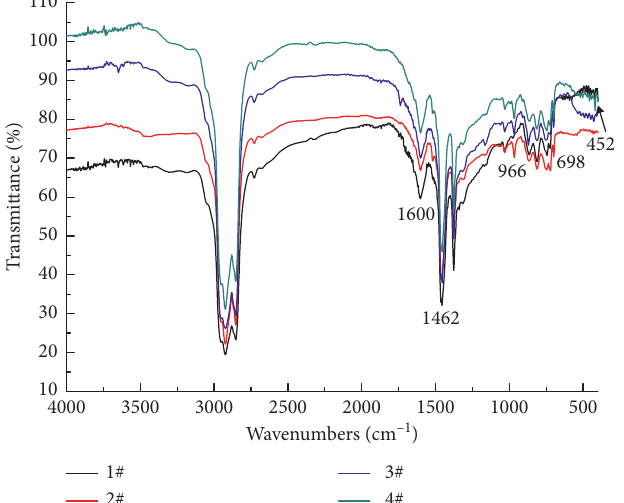
Figure 4: FTIR spectra of base asphalt and modified asphalt. 1# (base asphalt), 2# (SBS-modified asphalt), 3# (nano-ZnO/SBS-modified asphalt), and 4# (nano-ZnO/nano-TiO 2 /SBS-modified